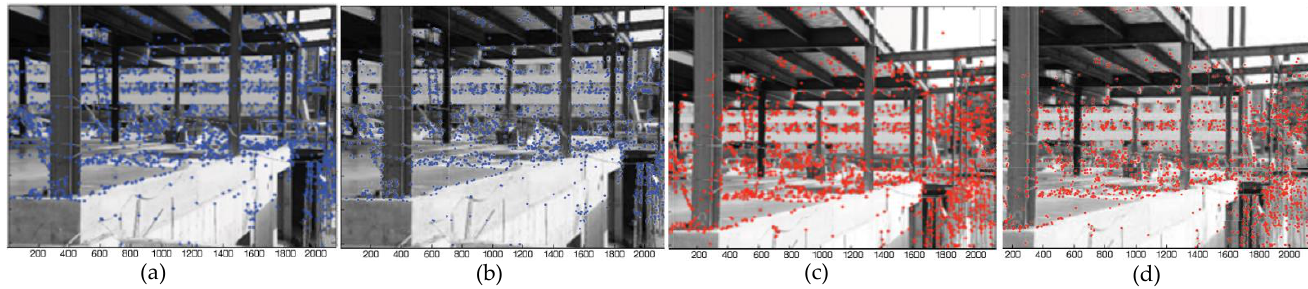
Figure 3. Left to Right: Visualizing keypoint matching between a pair of images shown as ( a ) Image1-Before RANSAC, ( b ) Image1-After RANSAC, ( c ) Image2-Before RANSAC, ( d ) Image2-After RANSAC [3].